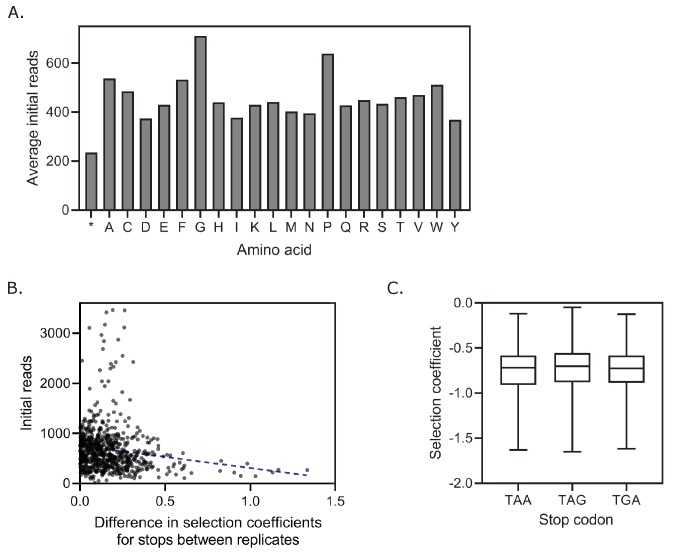
Analysis of variation in stop codon selection coefficients.(A) The average initial reads measured per codon for each amino acid. (B) The difference in the selection coefficients between stops in the two standard replicates compared to the initial reads for the corresponding stop in replicate 1. The blue dashed line indicates the line of best fit. R2 = 0.022, p<0.0001. (C) The distribution of selection coefficients for each stop codon in standard replicate 1.